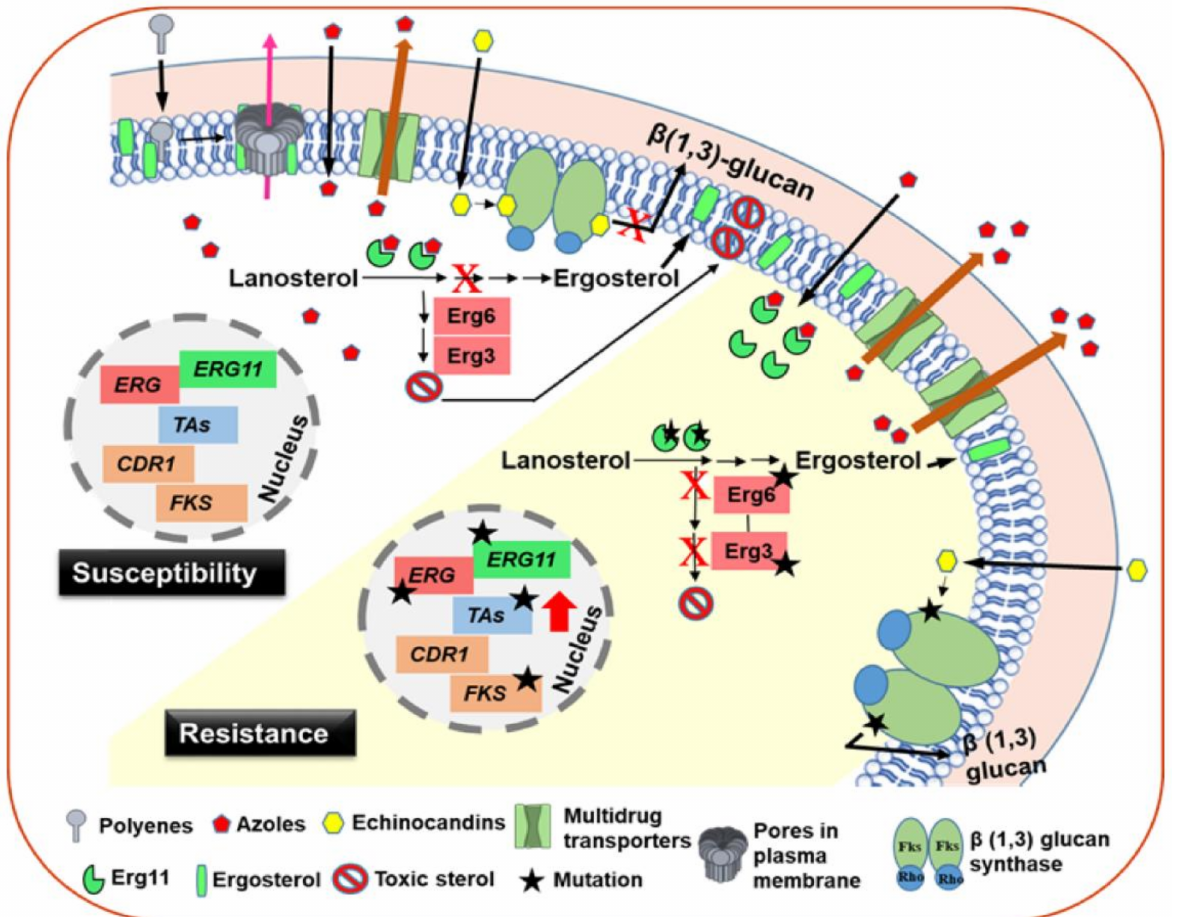
Figure 1. Prevalent resistance mechanisms towards azole, echinocandin and polyene antifungals. Gain-of-function mutations in the transcriptional activator (TA)-encoding genes ( TAC1 , MRR1 , PDR1 and UPC2A ) lead to amplification of their respective target genes. Overexpression of multidrug transporter and ERG11/Cyp51 genes are frequently observed in azole-resistant fungal isolates, as indicated by the red